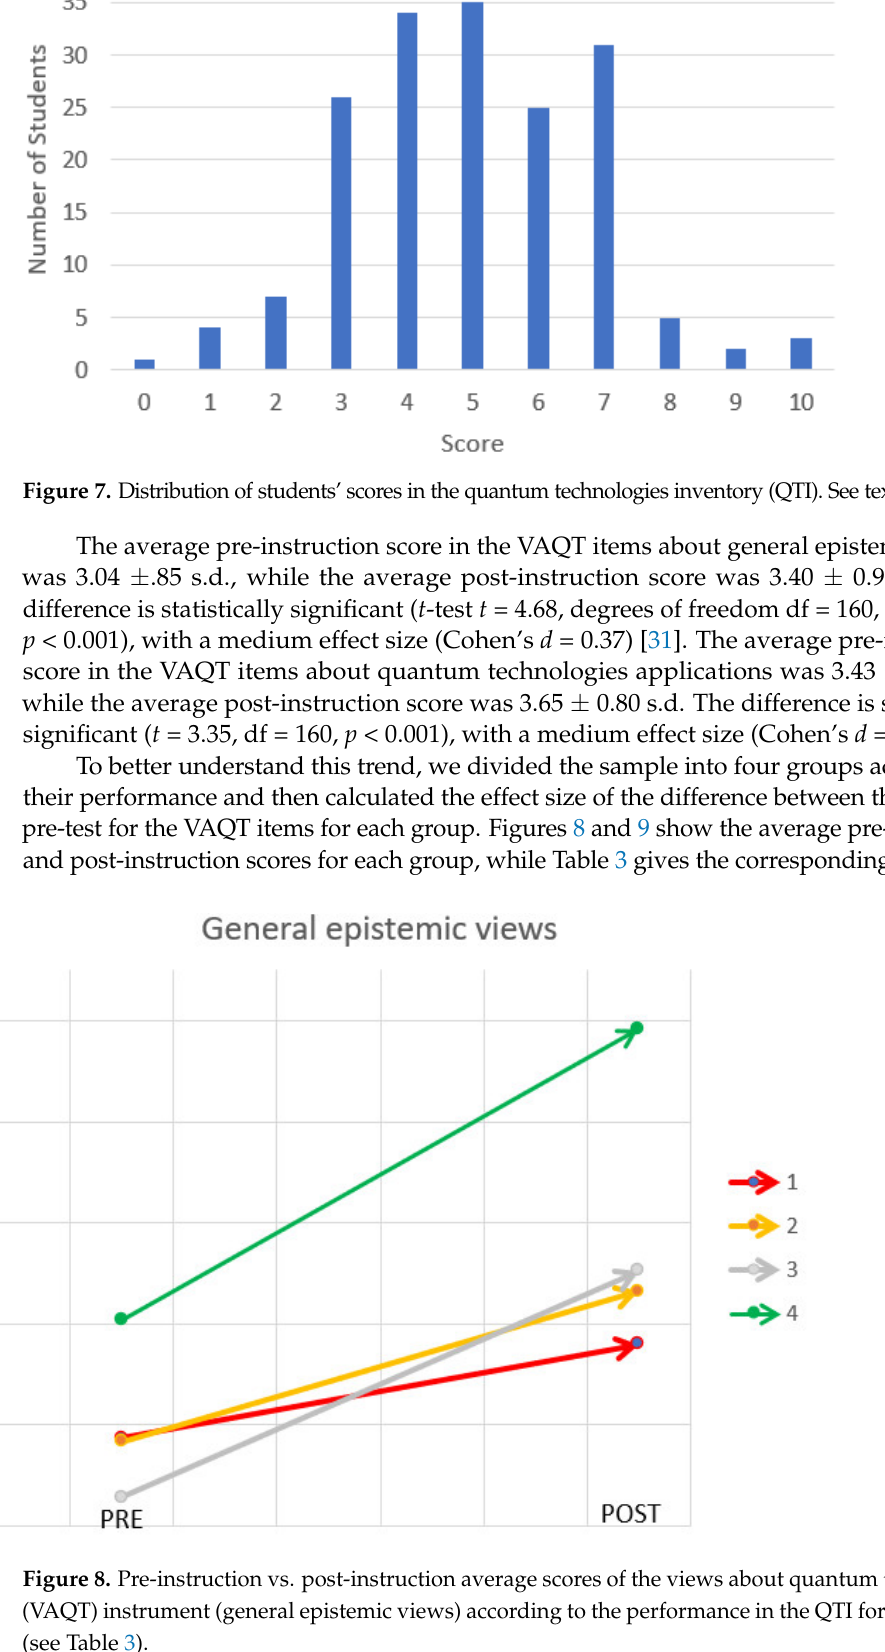
Figure 9. Pre-instruction vs. post-instruction average scores of the VAQT instrument (applications of quantum technologies) according to the performance in the QTI for four groups (see Table 3). 4. Discussion and Conclusions The analysis of the students’ answers to the QTI shows that, on average, the educational path was useful to familiarize students with fundamental aspects of quantum mechanics. Considering the fact that this was the first time the students tackled central concepts of quantum theory, the educational path was effective in focusing students’ attention on the fundamental concepts of quantum mechanics through the parallelism of information theory. About 40% of the students show a good knowledge of the measurement concept and of the wave function collapse, as measured by the QTI items. Similarly, on average, about 45% of the students seem to have grasped the concept of entanglement, which is not included in the national curriculum. Only about one-third of